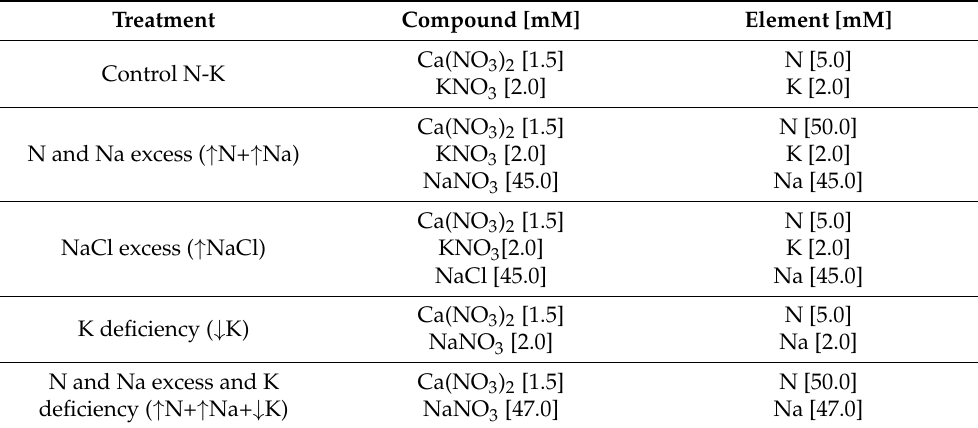
Table 1. Composition of the treatments used in this